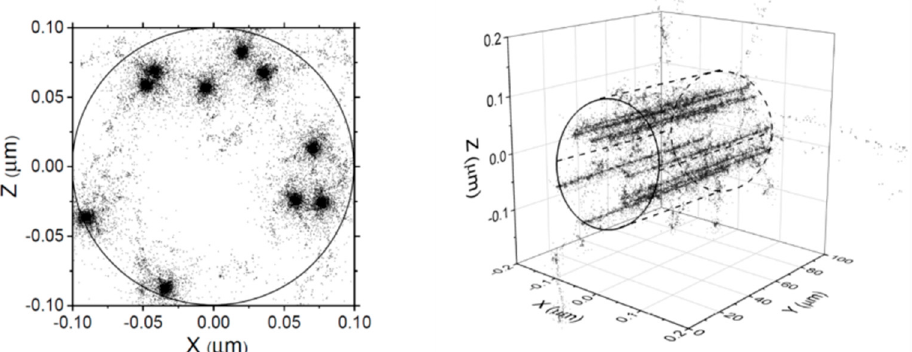
Figure 1. Irradiation model used in this work. ( Right panel ): a three-dimensional representation of a pulse of ten 300-MeV incident protons traversing through the solution calculated at ~1 picosecond (ps) from our Monte Carlo multi-track simulation code. All protons travel along the Y -axis over the whole track length used in the simulations (~100 µm). ( Left panel ): the figure shows a front view of the projections within a circle of radius R o = 0.1 µ m on the XZ plane (surface of the solution) for each track segment considered. Note the nonlinear track structure of the δ -rays that result from the knock-on collisions of the incident protons on water. Each dot marks the location of a reactive species. Adapted from Alanazi et al. [37].